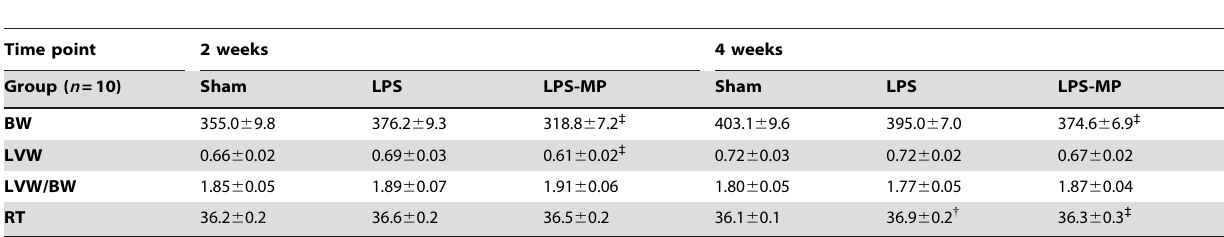
Table 1. Body weight (BW, g), left ventricular weight (LVW, g), ratio of the LVW to BW (LVW/BW, mg/g), and rectal temperature (RT, u C) in the